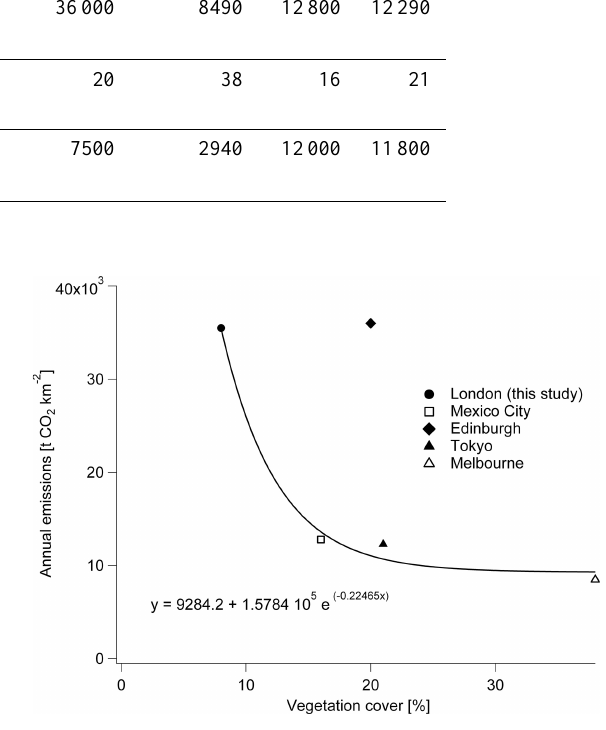
Fig. 10. Annual CO 2 emissions in five cities compared with vegetation